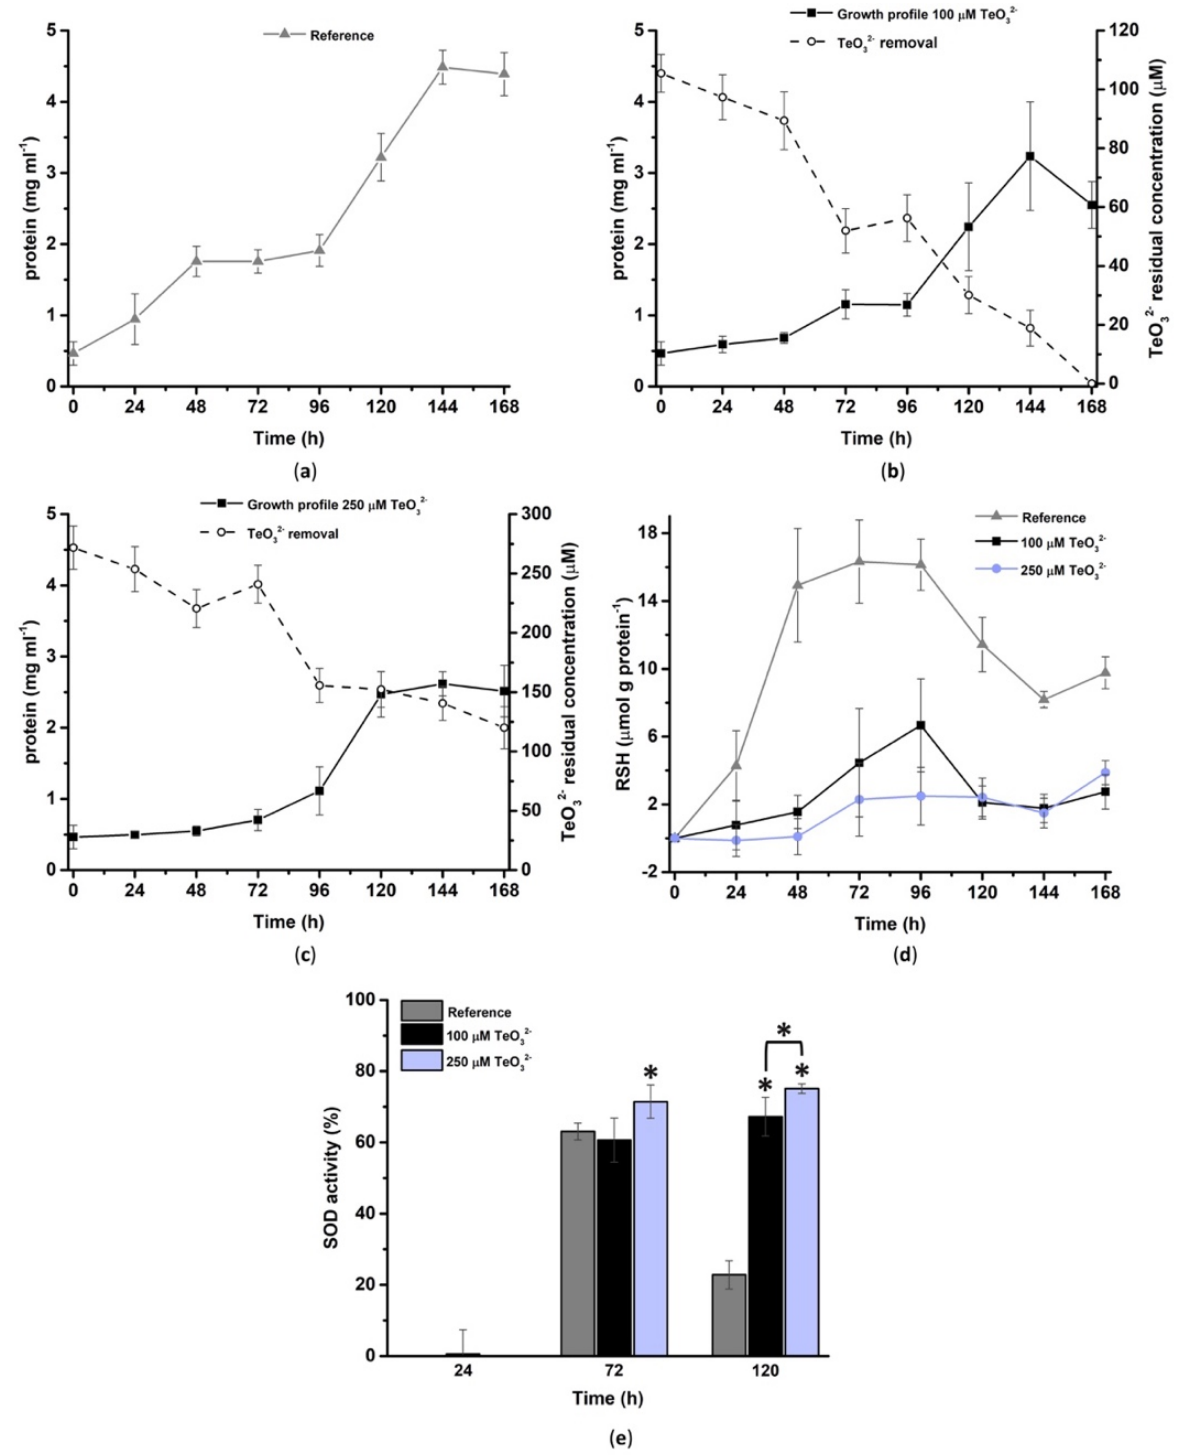
viable and non-viable cells, as indicated by the simultaneous green, red, and yellow fluo- rescence emission (Figure 4b,c). This evidence suggests that propidium iodide (red dye) can penetrate cells featuring damage to their cell membranes.